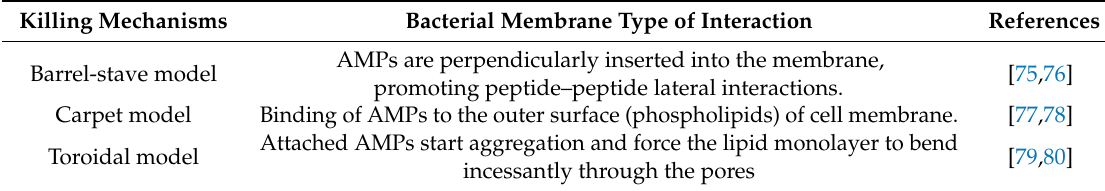
Table 1. Summary of the three most widely accepted mechanisms of antimicrobial peptides (AMPs). Killing Mechanisms Bacterial Membrane Type of